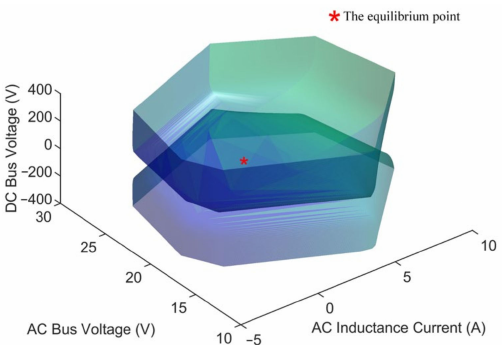
Figure 13. The 3D RAS of microgrids with the battery in discharging mode (CPLs power is 40 W).